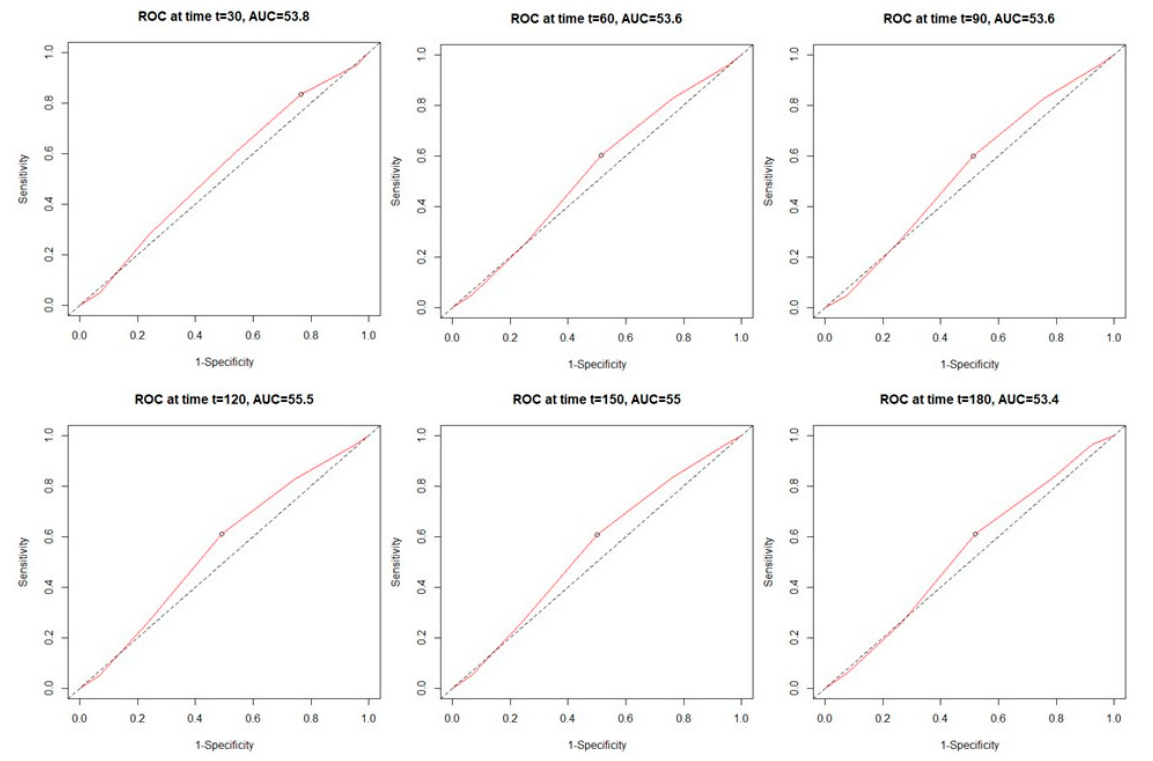
Figure 1. The time-dependent receiver operating characteristic (ROC) for all-cause mortality in the heart failure cohort.